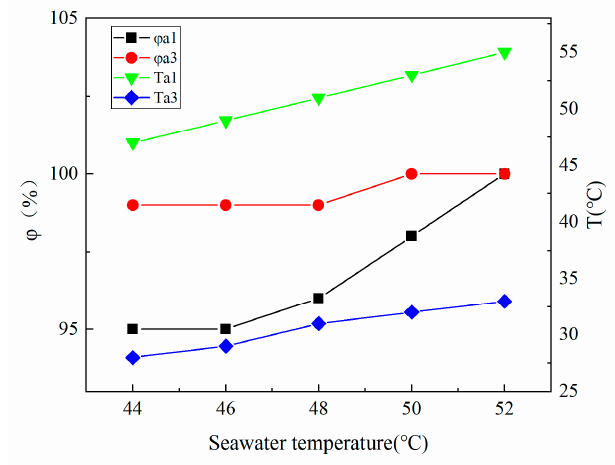
Figure 5. Effect of seawater temperature on relative humidity and air temperature.